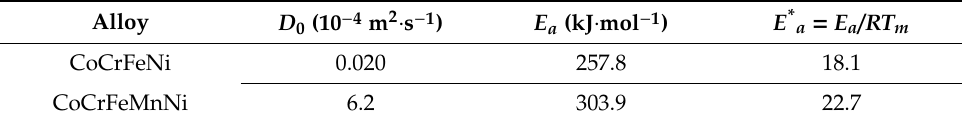
Table 6. Activation parameters for Ni di ff usion in CoCrFeNi and CoCrFeMnNi [31].